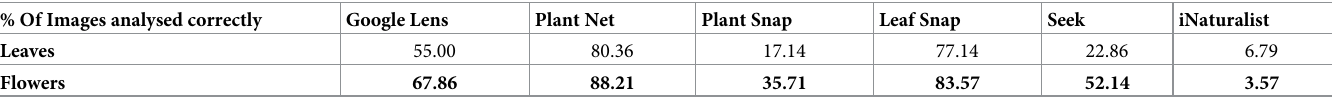
There was a significant difference between each plant ID app across the entire data set, with Plant Net being the most successful app at accurately identifying native Irish herbaceous angiosperms in the field. This was closely followed by Leaf Snap. Google Lens and iNaturalist both did well and Plant Snap and Seek were the lowest preforming apps in this study. This ranking of the apps was consistent across all families. The higher-ranking apps scored the highest points in all families and the lower ranking apps scored the lowest points. Plant Net is the leading app across all families, scoring significantly higher than the lowest scoring app, Plant Snap ( p < 0.0001). The consistency of the apps across different families suggests that the higher scoring plant ID apps (Plant Net and Leaf Snap) can reliably identify plants with a vari- ety of morphological features and characteristics because the three largest families in the study (Asteraceae, Fabaceae and Rosaceae) are morphologically distinct from each other. However, even with these high-scoring apps, they still failed to correctly identify plants between 12 and 23% of the time, highlighting that even the well-preforming apps continue to need develop- ment to improve accuracy. Plant Net correctly identified 88.21% of flower images and 80.36% of leaves to a species level on the first attempt in this study. This contrasts with the findings of Jones [15] and Bilyk et al. [21]. Neither study ranked Plant Net highest out of their selected apps, which included Google Lens, Seek and Plant Snap. Jones [15] analysed 38 images that included plant organs and whole plants, using nine free-to-use plant ID apps. These images captured a variety of life forms and plant organs including flowers, leaves, bark, herbs, monocots and woody plants. They also utilised multiple scoring systems, taking taxonomic accuracy and single scores into account for their analysis. Scores were awarded for correctly identifying plants to a species, Table 6. Percentage of correctly identified leaf and flower images for all species across all apps. % Of Images analysed